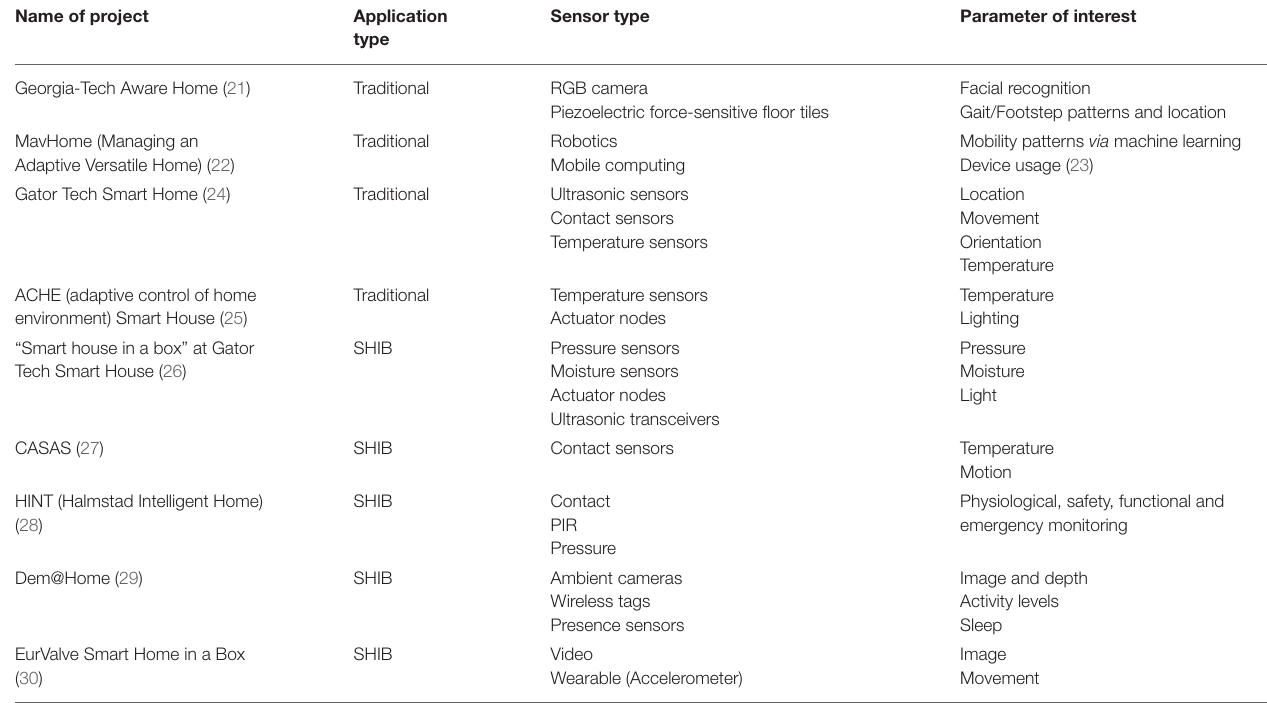
TABLE 1 | Smart Home approaches and sensors